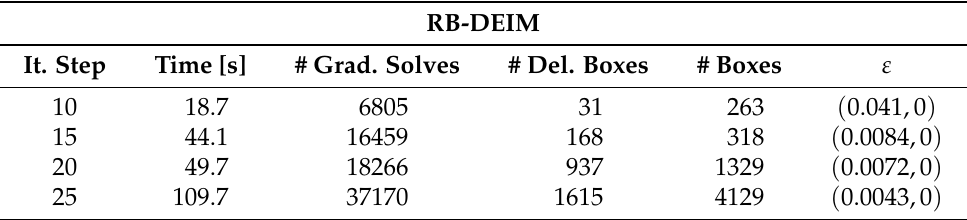
Table 5. Modified subdivision algorithm with the modified descent